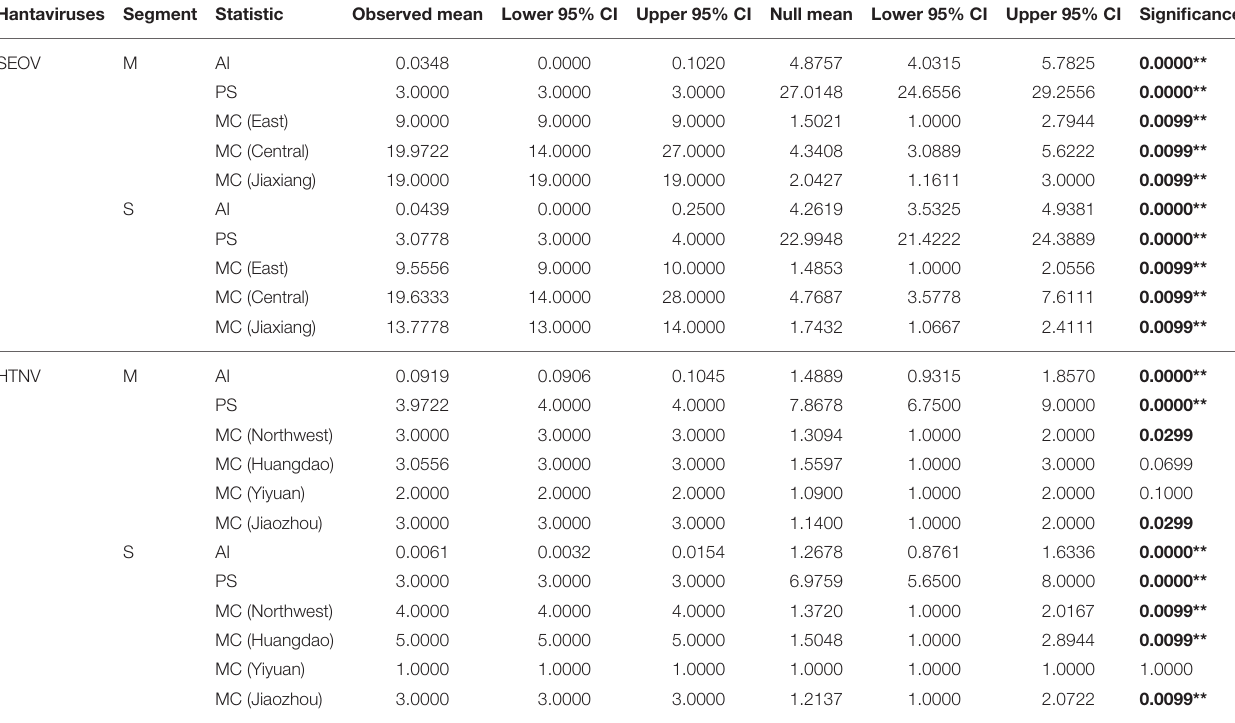
TABLE 3 | Region-phylogeny association parameters of hantaviruses in Shandong Province (three states for SEOV and four states for HTNV). Hantaviruses Segment Statistic